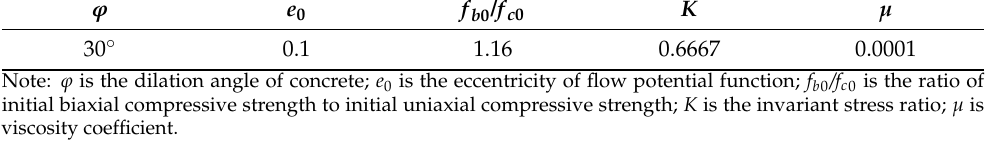
Table 3. Material properties of steel bar.